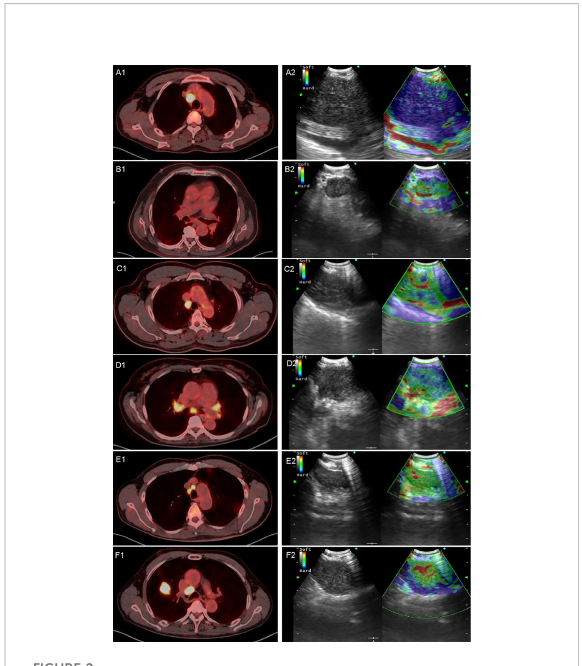
FIGURE 2 Representative images of PET/CT and elastography in a variety of diseases. A1 and A2 are representative true-positive images of malignant LNs examined by PET/CT and elastography, which showed a 4R LN with adenocarcinoma; B1 and B2 show a 7 LN with nonspeci fi c lymphadenitis, true-negative results in both elastography and PET/CT; C1 and C2 show a 4R LN with tuberculosis, and PET/CT showed high metabolism with an SUVmax of 7.85 and a TLG of 39.09. In contrast, elastography showed a grading score of 3 and a mean hue value of 117.74; D1 and D2 showed a 7 LN with sarcoidosis, in which PET/CT showed a high metabolism while elastography showed soft tissue. SUVmax, TLG, grading score, and mean hue value were 5.5, 22.06, 3, and 105.84, respectively; E1 and E2 showed a 4R LN with nonspeci fi c lymphadenitis, false positive by PET/CT but true negative by elastography, and SUVmax, TLG, grading score, and mean hue value were 7.84, 11.33, 1, and 89.37, respectively; F1 and F2 show a 4R LN with neuroendocrine tumor not otherwise speci fi ed, and PET/CT showed high metabolism with an SUVmax of 13.29 and a TLG of 42.19. However, elastography shows false-negative results with grading score of 3 and mean hue value of 124.42. LN, lymph node; SUVmax, maximal standardized uptake value; TLG, tumor lesion